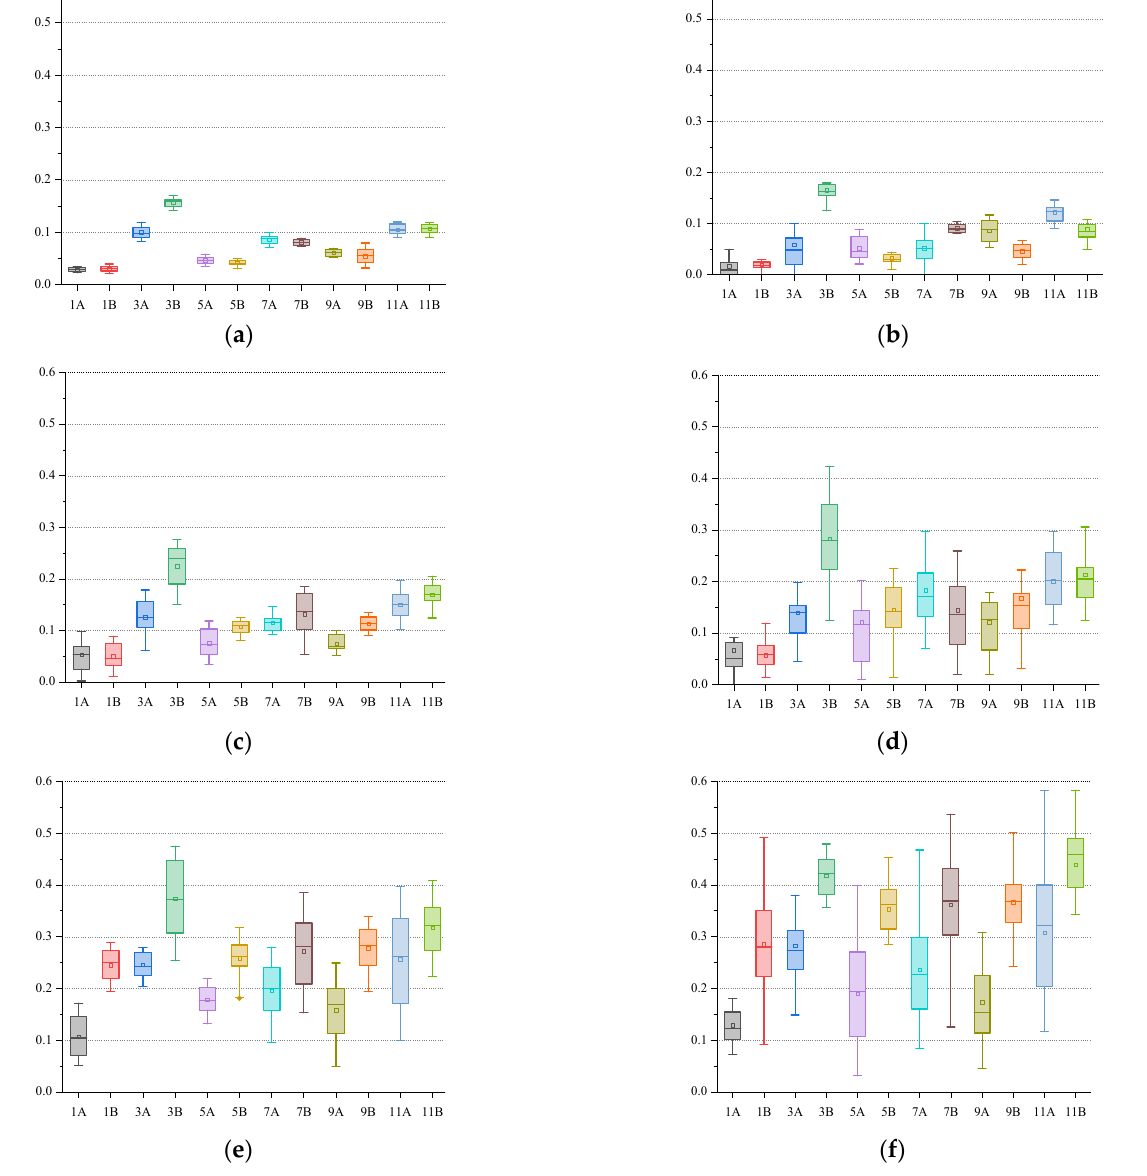
Figure 13. IDG box plot comparison: ( a ) NSGA-III-L; ( b ) NSGA-III-NL; ( c ) NSGA-II-L; ( d ) NSGA-II-NL; ( e ) RWGA-L; ( f ) RWGA-NL. The upper line of the box is the upper 1/4 median 1 Q , the middle line of the box is Q , the lower line of the box is the lower 1/4 median 3 the median 2